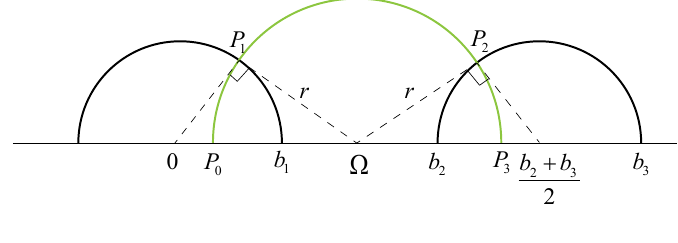
Figure 20 . The distance between two geodesics, denoted by black circles, is the geodesic length between P 1 and P 2 on the green